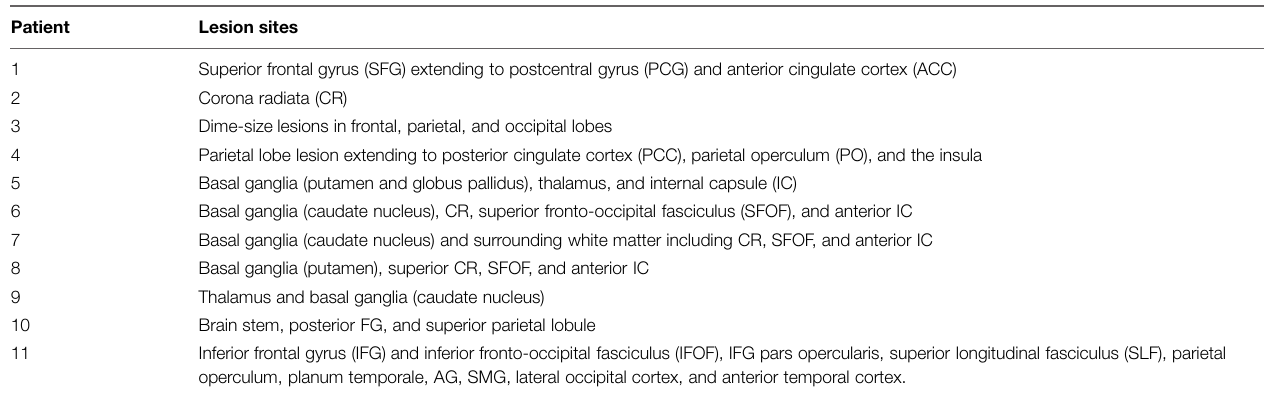
Figure 3 . Overall, lesions fell primarily in the middle cerebral artery territory and covered medial temporal, frontal, parietal and occipital cortices, middle temporal cortex, basal ganglia, inferior frontal and superior parietal cortices, as well as the underlying white matter.